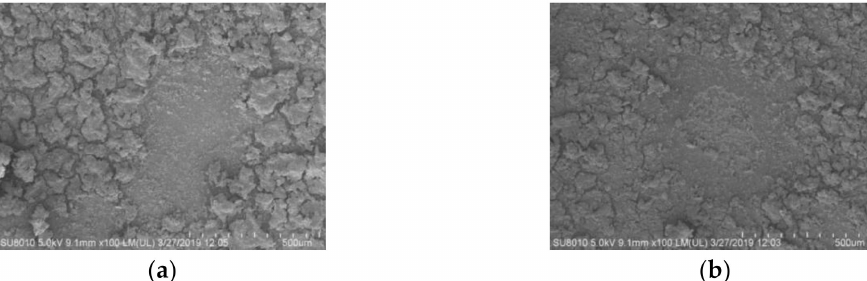
Figure 3. Distribution of the natural pollutions on the surface of the insulator ( a ) SEM image of the entire ablated sample top, ( b ) SEM image of the entire ablated sample bottom.